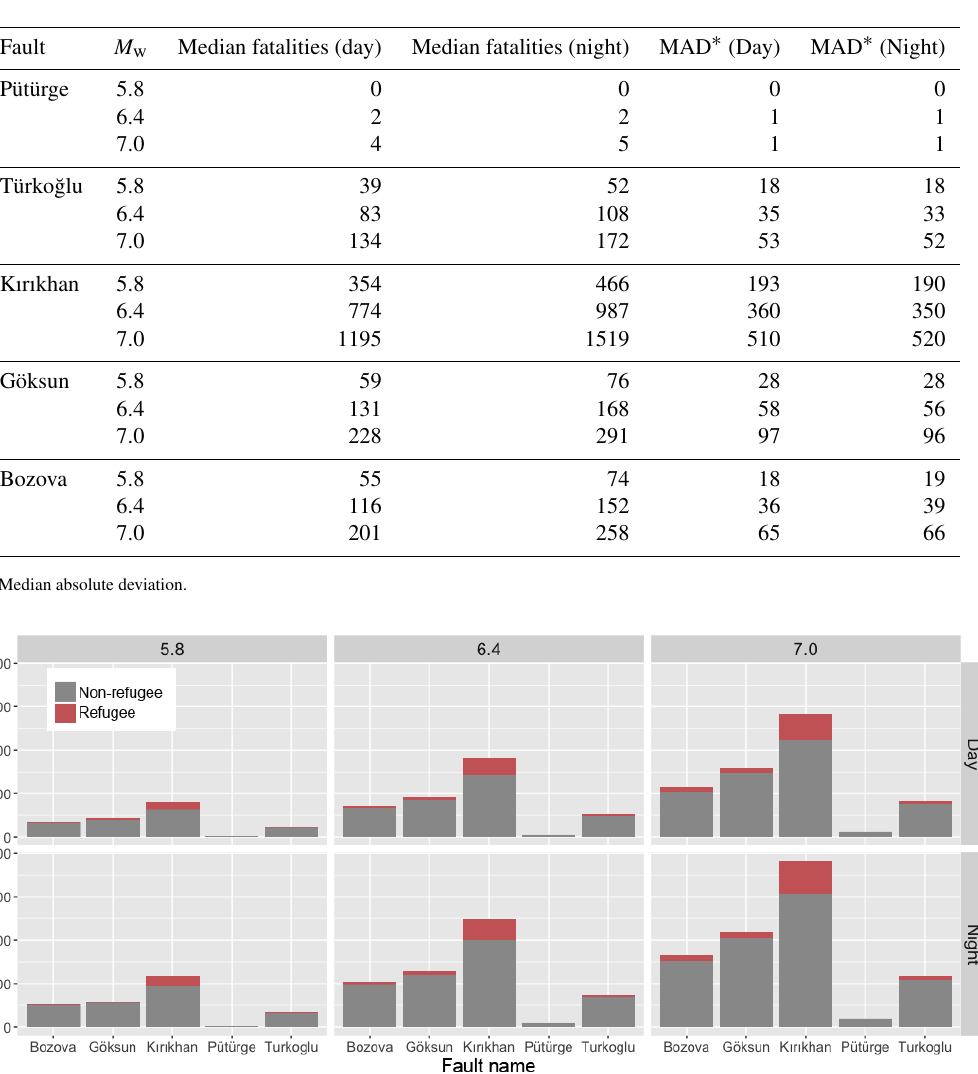
Table 5. Median fatality estimates for refugee populations.